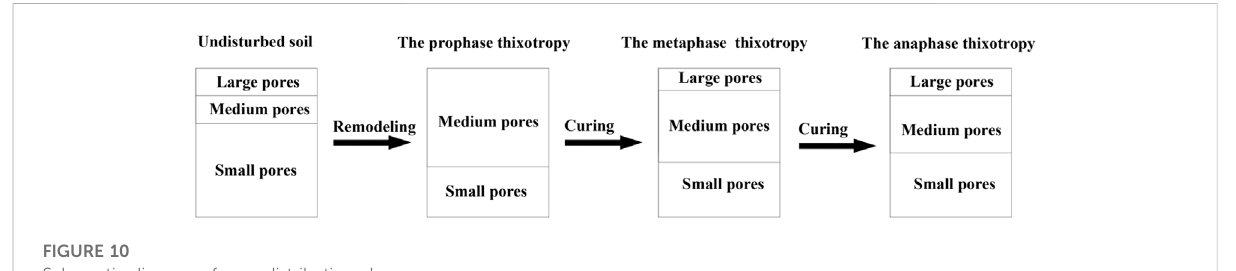
FIGURE 10 Schematic diagram of pore distribution